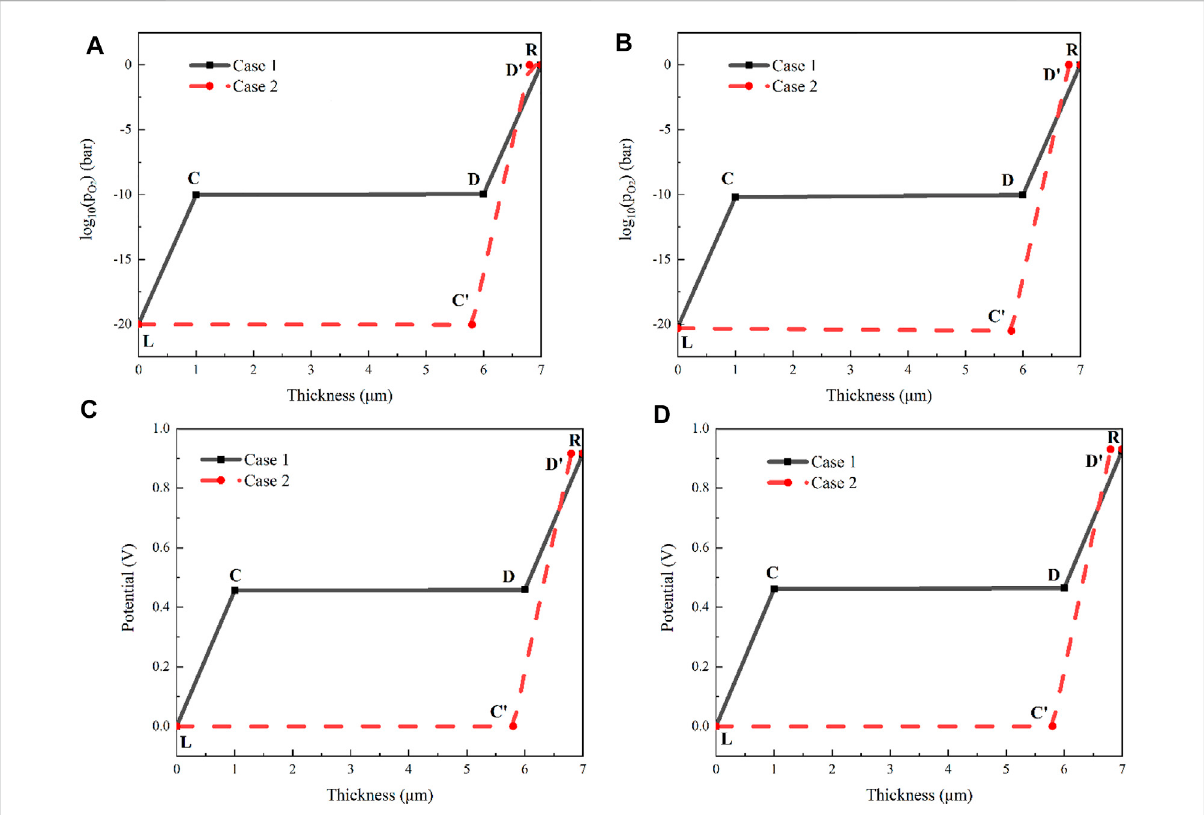
FIGURE 12 Comparison of the two multilayer electrolytes when the operating temperature is 600 ° C: (A) oxygen partial pressure under the current density of 0.17A/cm 2 ; (B) oxygen partial pressure under the current density of 0.7A/cm 2 ; (C) potential under the current density of 0.17A/cm 2 ; (D) potential under the current density of 0.7A/cm 2